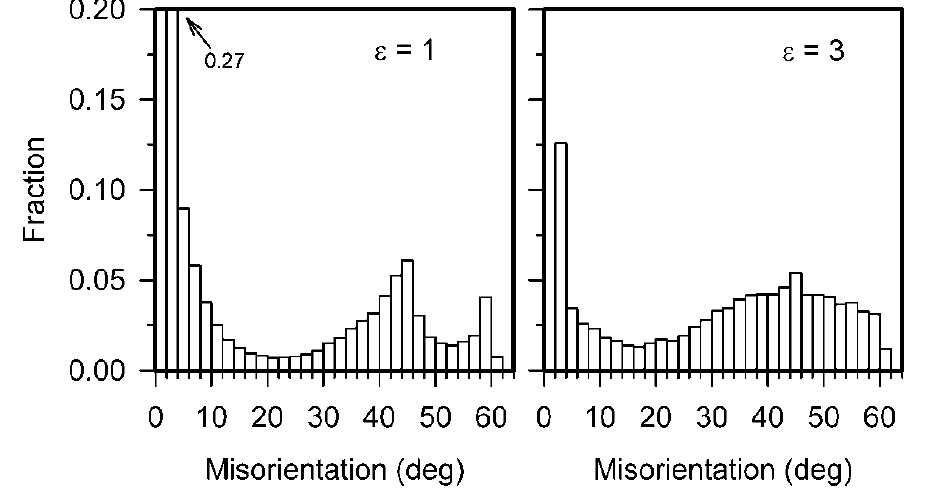
Figure 4. Grain boundary misorientation distributions evolved in a 304L stainless steel subjected to cold rolling to total strains of ε =1 and ε =